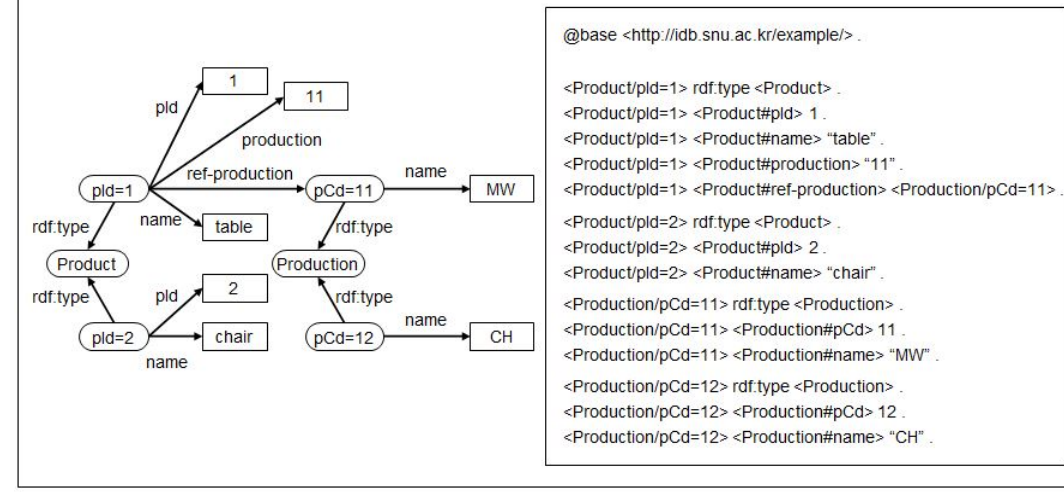
Figure 5. An example result of the direct mapping.